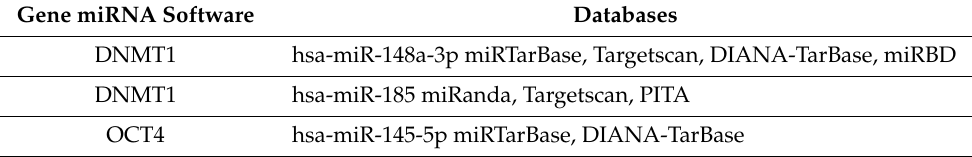
Table 1. Target genes and miRNAs selected using the indicated bioinformatic tools.